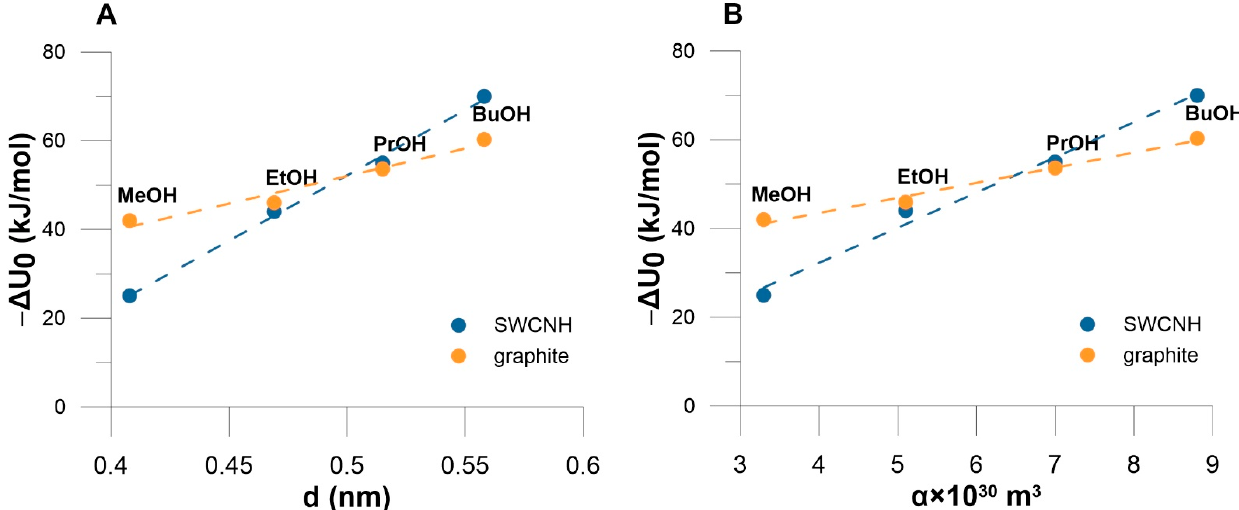
Figure 5. ( A ) The correlation between the enthalpy of adsorption at zero coverage and molecular diameter for adsorption on graphite and on SWCNH (DC = 0.9601 and 0.9963). ( B ) The correlation between the enthalpy of adsorption at zero coverage and molecular polarizability for adsorption on graphite and on SWCNH (DC = 0.9872 and 0.9877).